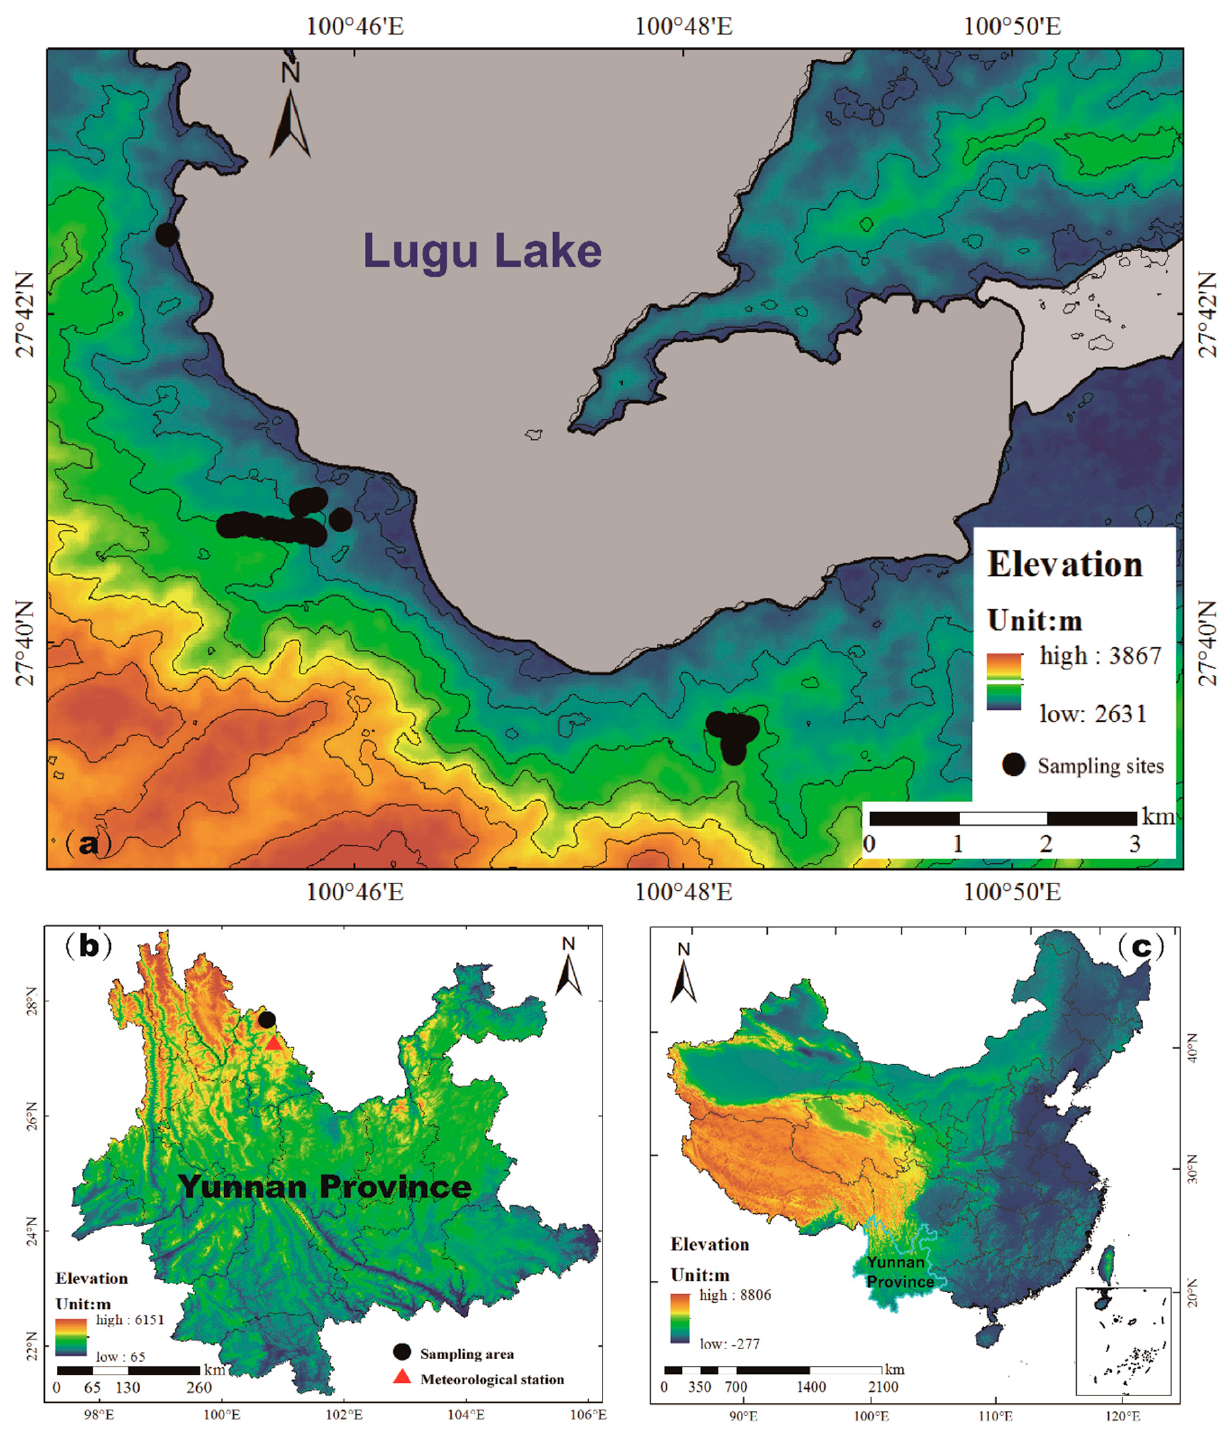
Figure 1. Topographic maps showing the locations of sampling sites in the Lugu Lake watershed ( a ), the locations of the study area and Ninglang meteorological station in Yunnan Province ( b ), and the location of Yunnan Province in China ( c ).